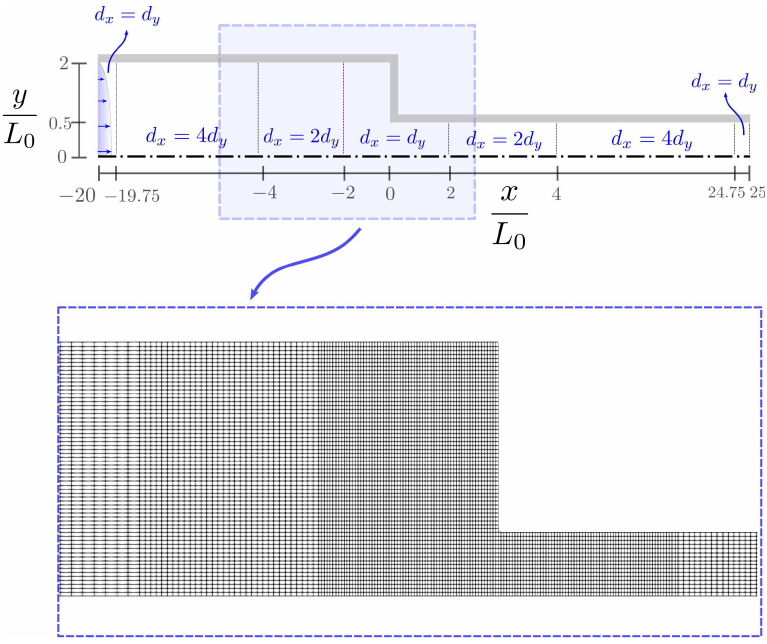
Figure 3. Computational domain used in OpenFOAM for the contraction problem. Table 1. Numerical schemes in